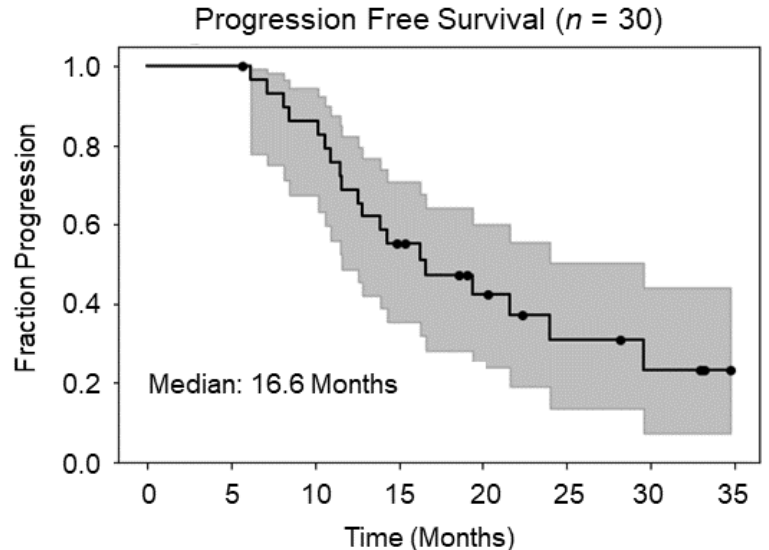
Figure 3. Kaplan – Meier estimator for PFS; median PFS: 16.6 months with a median time to follow- Figure 3. Kaplan–Meier estimator for PFS; median PFS: 16.6 months with a median time to follow-up up of 20.3 months. of 20.3 months.